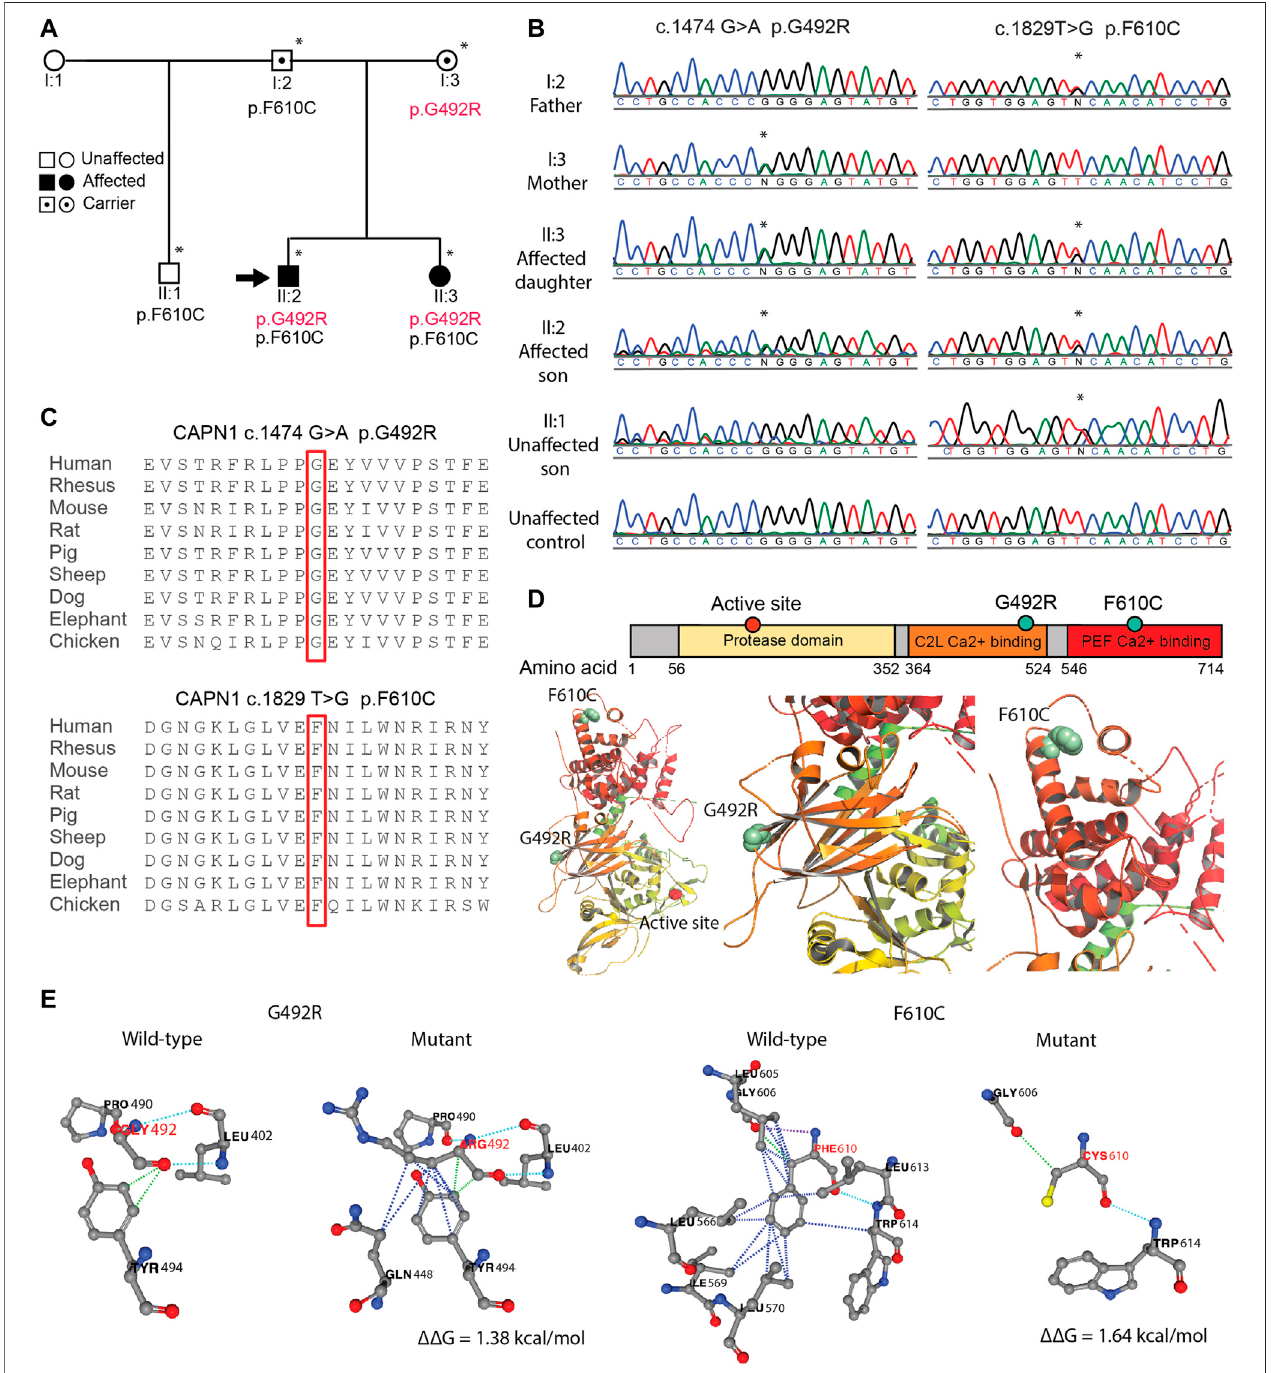
FIGURE1| SMA4causativep.G492R/p.F610Ccompound hetmutationin CAPN1 . (A) PedigreeofSMA4family.Squaresindicatemale,circlesindicatefemales. Solid symbols denote affected individuals and open symbols unaffected individuals. Carriers are represented with internal dots. Asterisk indicates individuals in which whole exomes sequencing was performed and the black arrow shows the proband. (B) Sanger sequencing con fi rms the nucleotide changes c.1474G > A (p.G492R) and c.1829T > G (p.F610C) in the two affected siblings (II:2 and II:3). (C) The substituted amino acid residues (p.G492 and p. F610) are located within highly conservedfunctionaldomainsofthe CAPN1 protein. (D) CAPN1 secondary structure displayingtheproteasedomain(yellow)andtheC2domain-like(C2L,orange)and penta-EF-hand (PEF, red) Ca 2+ binding domains bearing the p. G492R and p. F610C mutations respectively. Affected residues located in the 3D ribbon structure of CAPN1 using PyMOL and the Rattus norvegicus CAPN1 crystalized structure (PDB:1QXP). (E) The impact of the p. G492R and p. F610C missense mutations in the protein stability ( ΔΔ G) of CAPN1 predicted using the PremPS online tool. For clarity, the ribbon was hidden and only the non-covalent interactions affected by the substitutions are displayed. Dotted lines represent hydrophobic (blue), polar (light blue), hydrogen bonds (violet) and Van der Waals (green) interactions in the wild-type and mutant structures. Positive ΔΔ G predicts a reduction in the stability of the resulted protein.